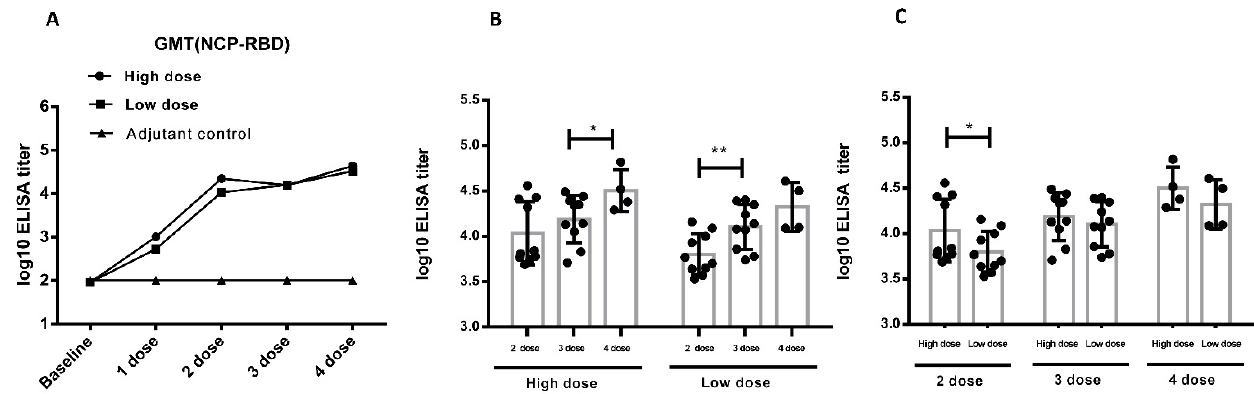
Figure 5. Neutralizing antibody in immunized cynomolgus monkeys based on pseudoviruses (the immunization procedure: 0 W-4 W-8 W-10 W, 4 times, n = 10 animals/group, n = 4 animals/group during recovery period). ( A ). The level of neutralizing antibody in serum of cynomolgus monkeys during the study (mixed serum). ( B ). A comparison of the neutralizing antibody analysis between different immunization periods in cynomolgus monkeys (individual sera) ( C ). Comparison of the neutralizing antibody analysis between different dose in cynomolgus monkeys (individual sera). * p < 0.05, ** p < 0.01. Data were presented as Mean ± SD.